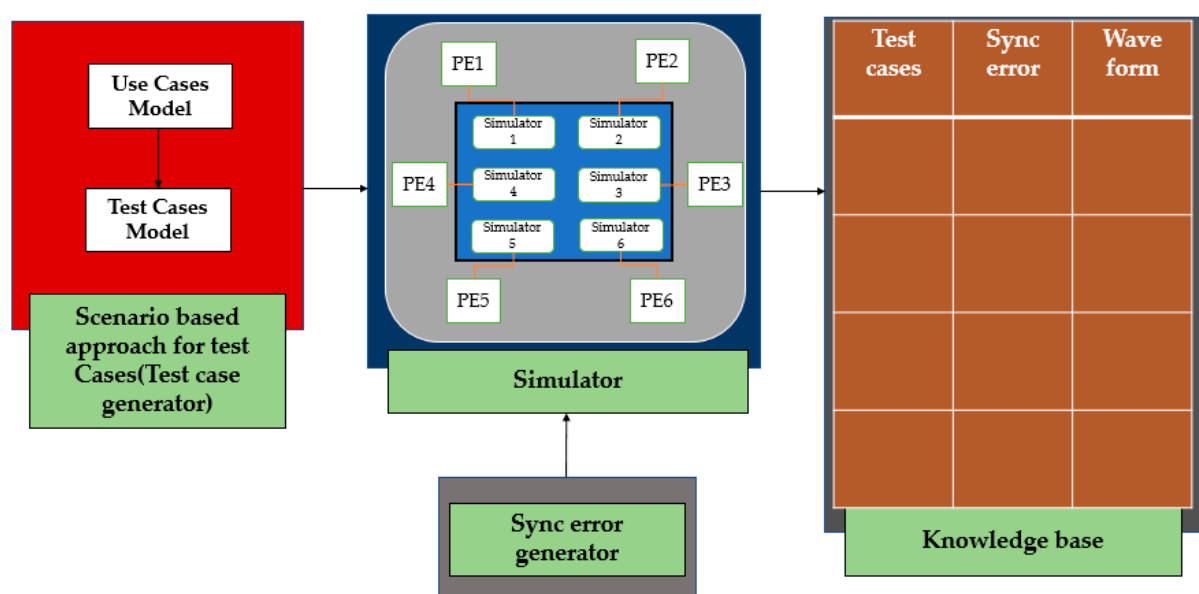
Figure 3. Creation of knowledge base technique .